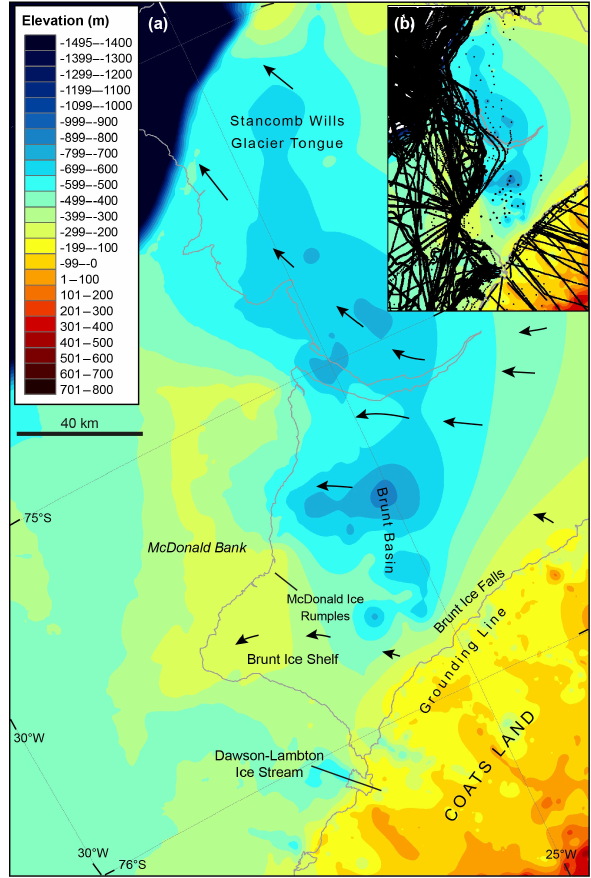
Figure 5. (a) Submarine geomorphology under the Brunt Ice Shelf and Stancomb-Wills Glacier Tongue (BIS–SWGT) showing that the Brunt Basin consists of a NNW-oriented glacial trough beneath the BIS and SWGT, separated from the Filchner Trough by the McDon- ald Bank. This image was compiled from multiple data sources, in- cluding multibeam and single beam bathymetric data incorporating historical ship tracks inland of the present ice-shelf front, the In- ternational Bathymetric Chart of the Southern Ocean data (IBSCO; Arndt et al., 2013) and seismic surveys of the depth to the seabed from the surface of the BIS–SWGT. Black arrows depict contem- porary ice-flow directions. (b) Data density including locations of ship tracks (solid black lines offshore), historical depth soundings (dots on the SWGT) radar surveys (solid back lines over the inland ice) and ice-shelf seismic survey points (dots on the BIS).